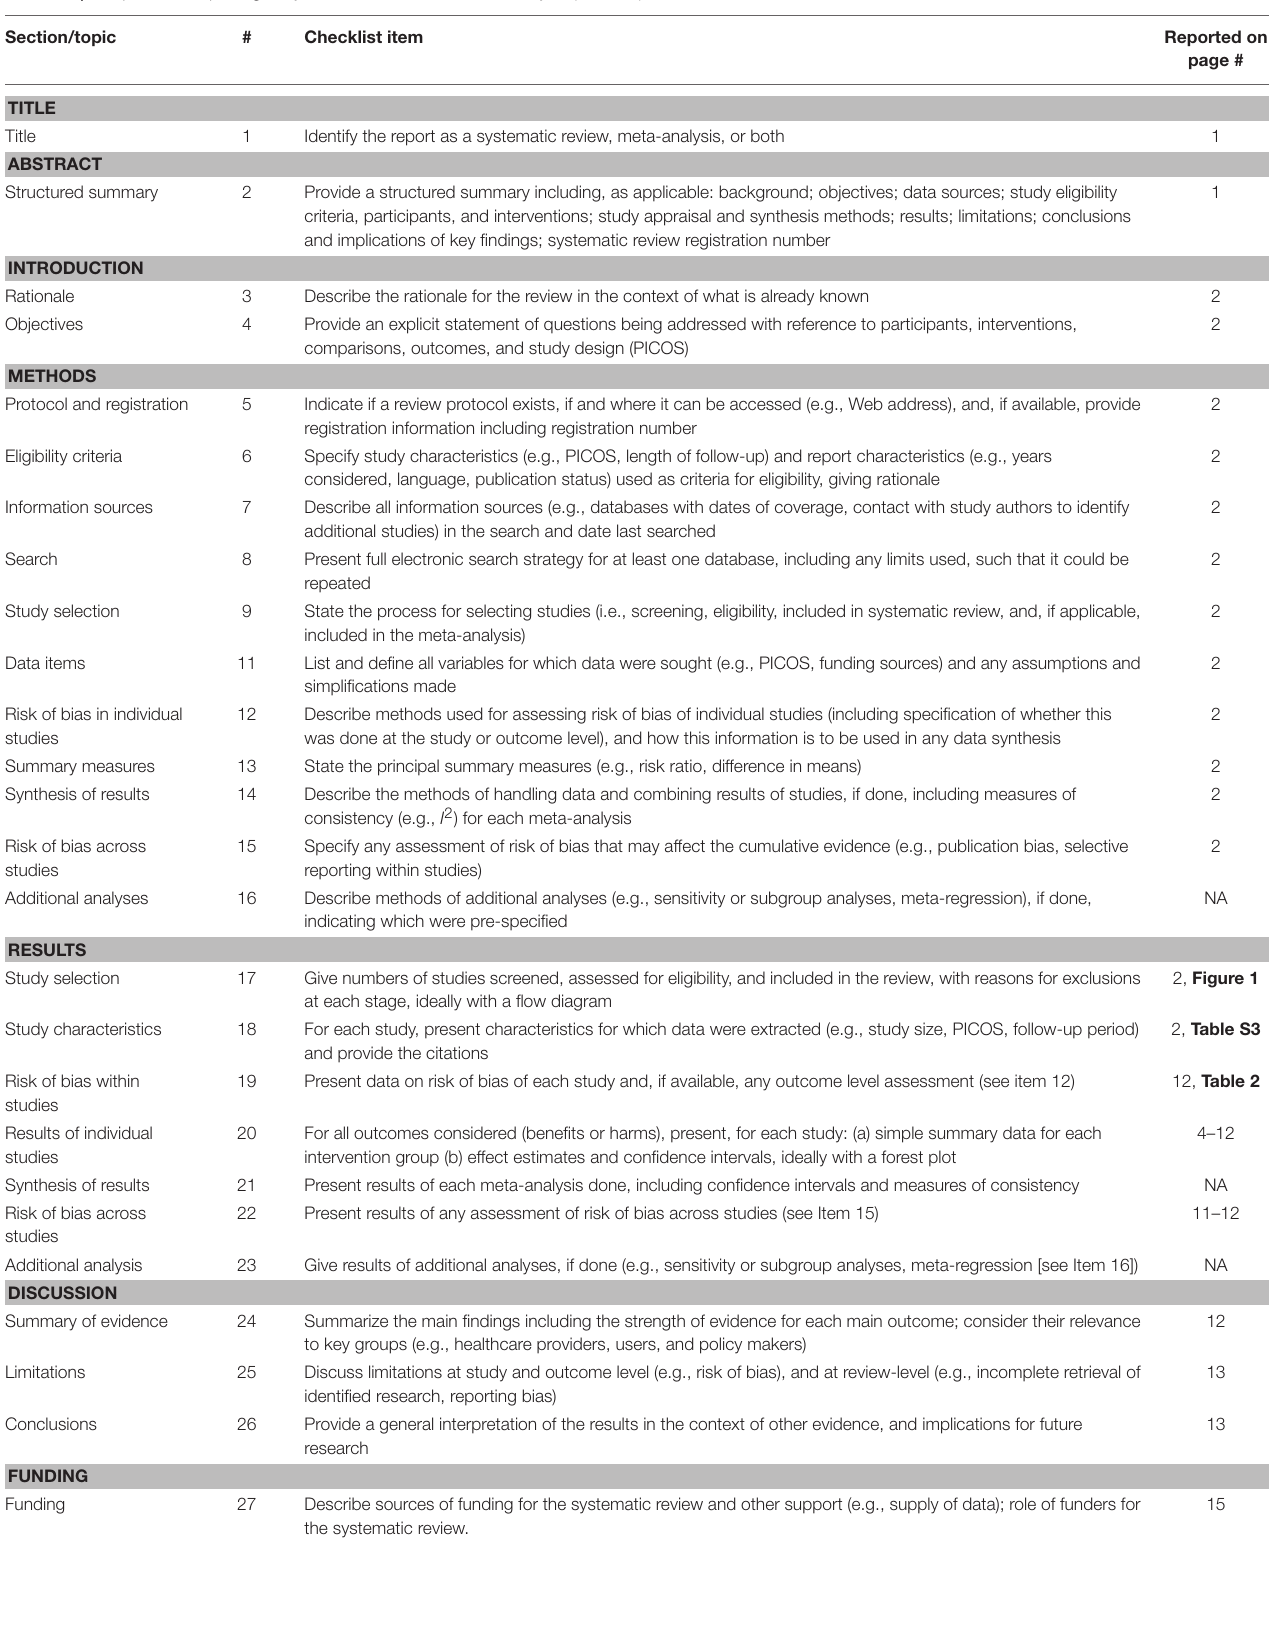
TABLE 1 | The preferred reporting of systematic reviews and meta-analysis (PRISMA)